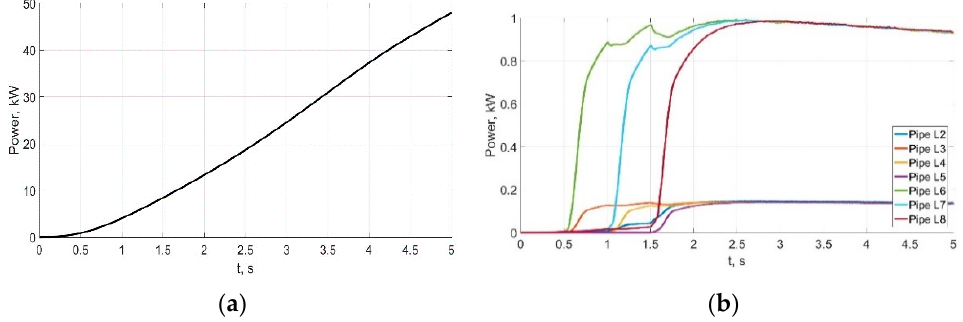
Figure 16. Hydraulic energy losses. Note: ( a ) Hydraulic energy losses in the 1st pipeline (L1); ( b ) Hydraulic energy losses in all pipelines and pipes.